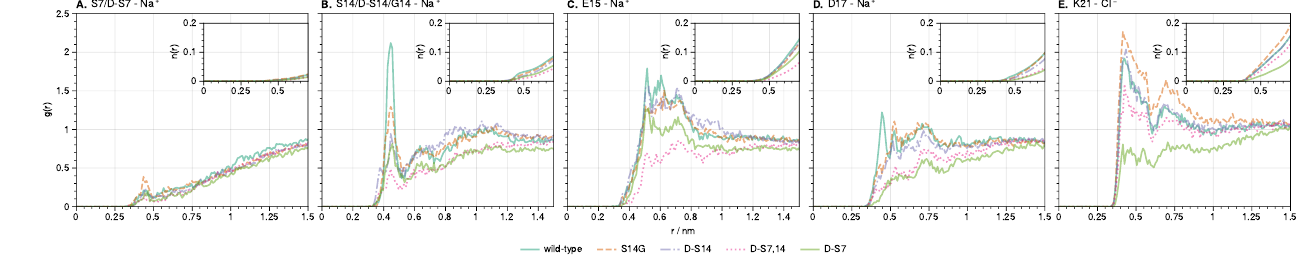
Figure 6. RDF of counter-ions around S7 ( A ), S14 ( B ), E15 ( C ), D17 ( D ) and K21 ( E ) from simulations in wild-type and mutations of HN. Insets show the average number of sodium or chloride ions around each site at 150mmolL − 1 salt concentration.